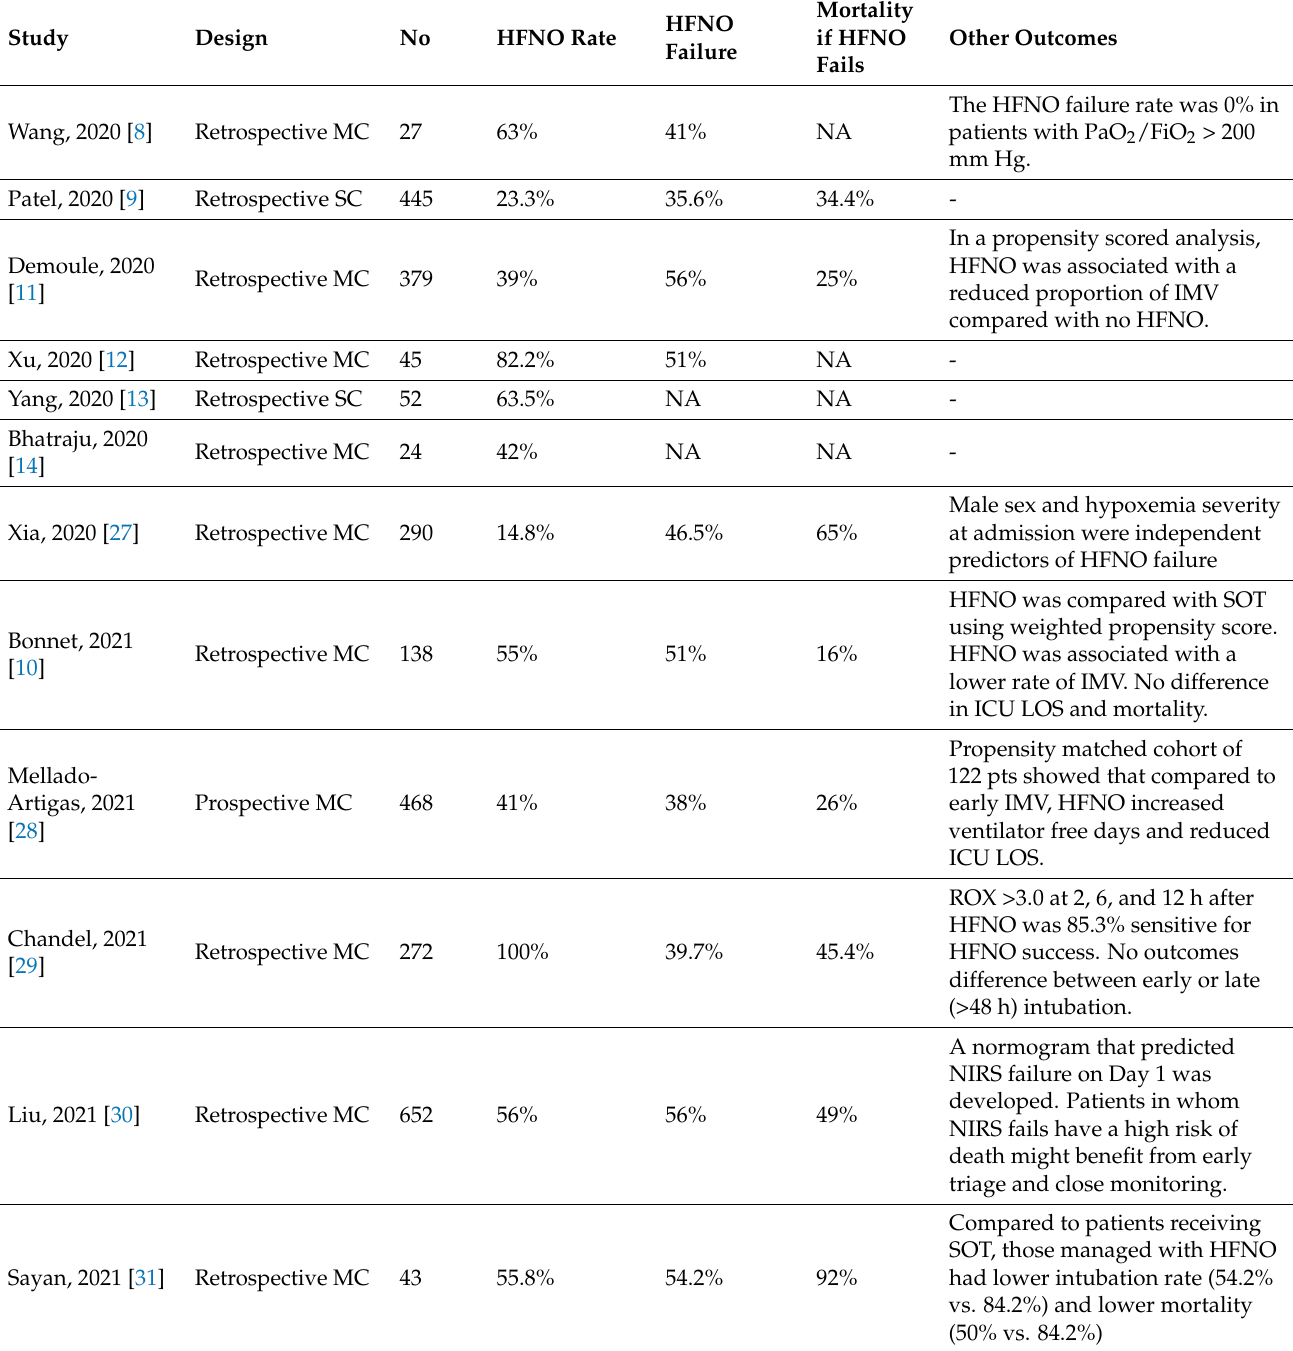
Table 1. Evidence for the use of High-Flow Nasal Oxygen in patients with COVID-19-associated hypoxemic respiratory